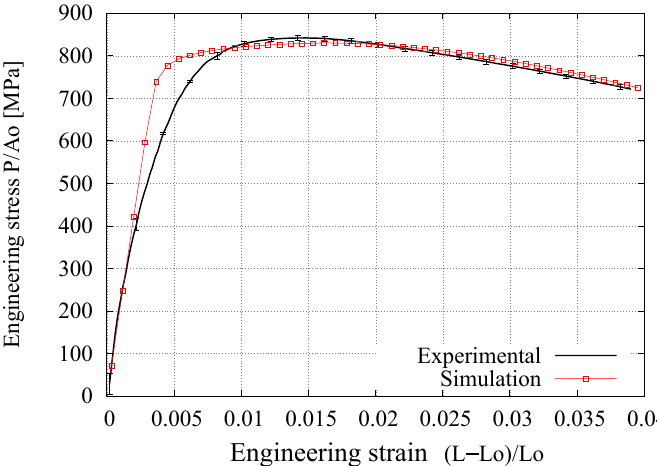
Figure 10. Average experimental and numerical results for the engineering stress–strain relationship, normalized root-mean-square deviation (NRMSD) = 4.67%.